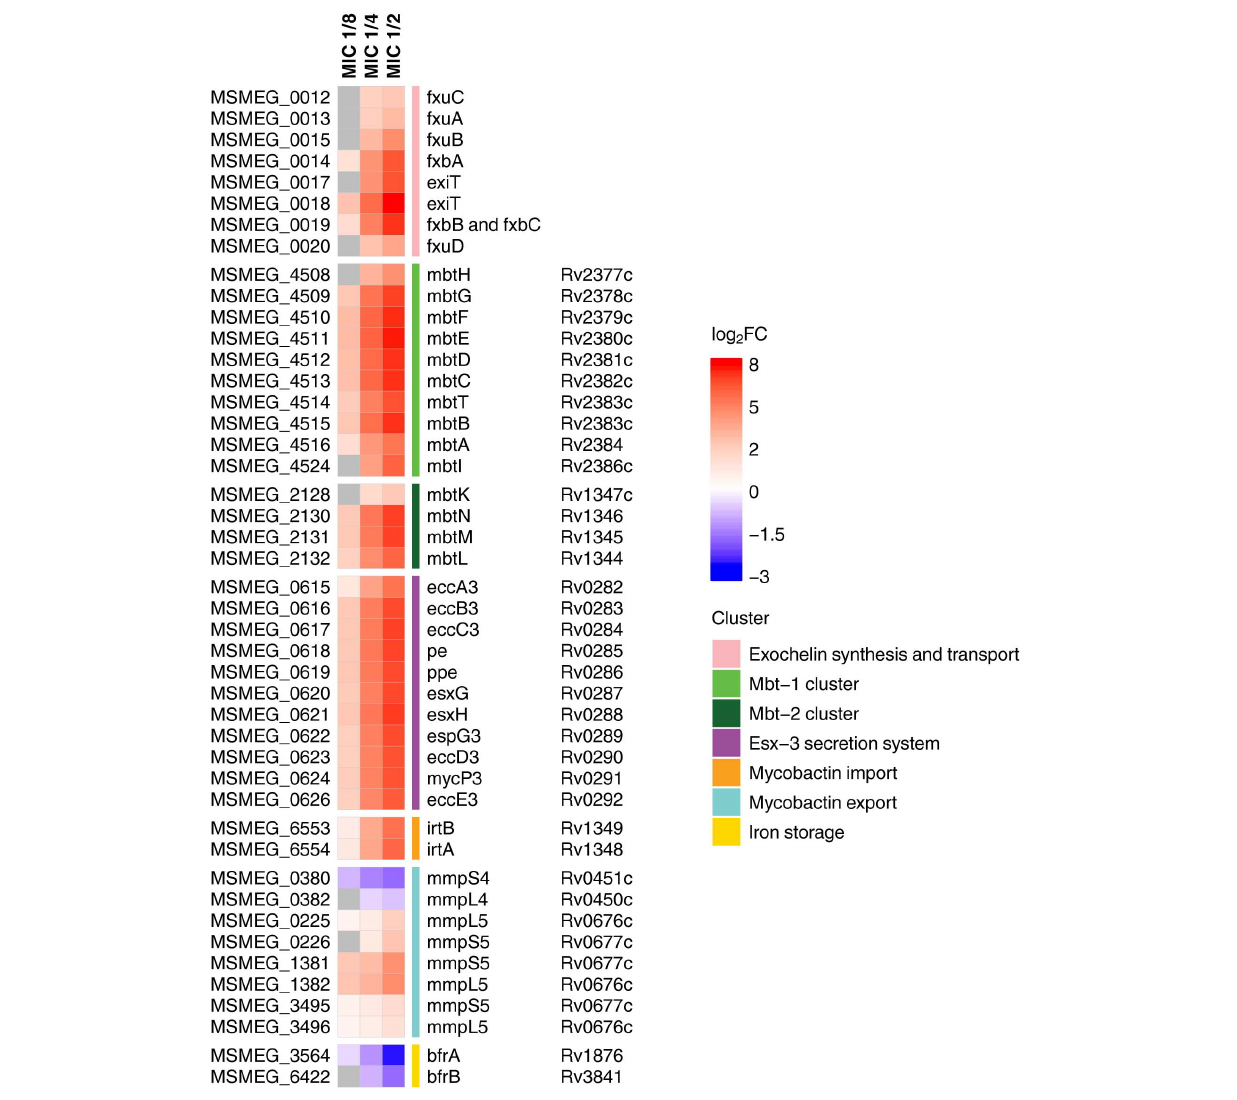
FIGURE 2 | Heatmap showing log 2 -transformed fold change in expression levels of iron metabolites during 3a exposure. M. smegmatis mc2 155 locus tags (MSMEG_*) are indicated to the left of the heatmap, and M. tuberculosis H37Rv locus tags (Rv*) are indicated to the right of the heatmap, genes’ names are relative to M. smegmatis mc2 155 . Genes with FDR > 0.001 are shown in